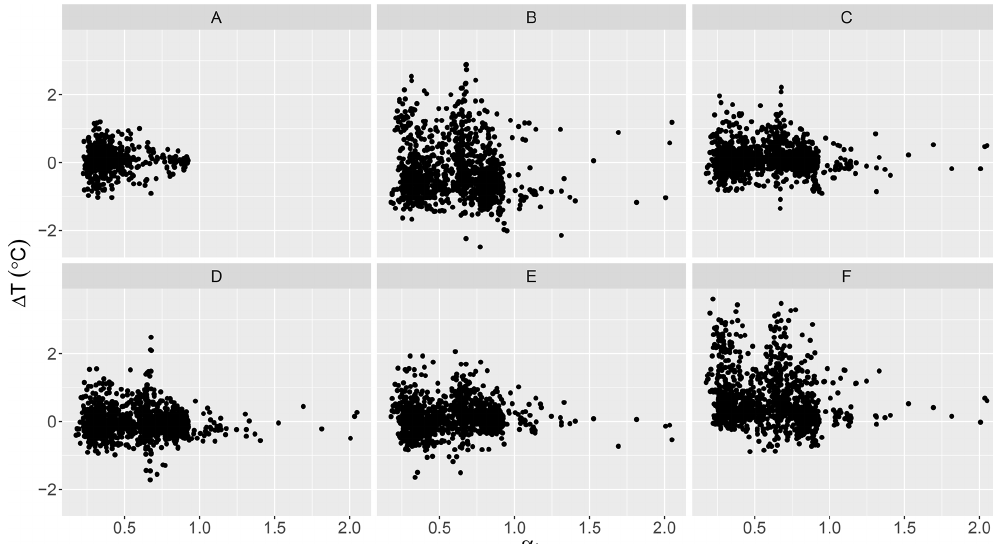
Figure 8. Plots of the albedo of site b(α b ) vs. temperature differences between instruments in each pair. The two aggregations of data visible in some plots are due to the bimodality of albedo values (with or without